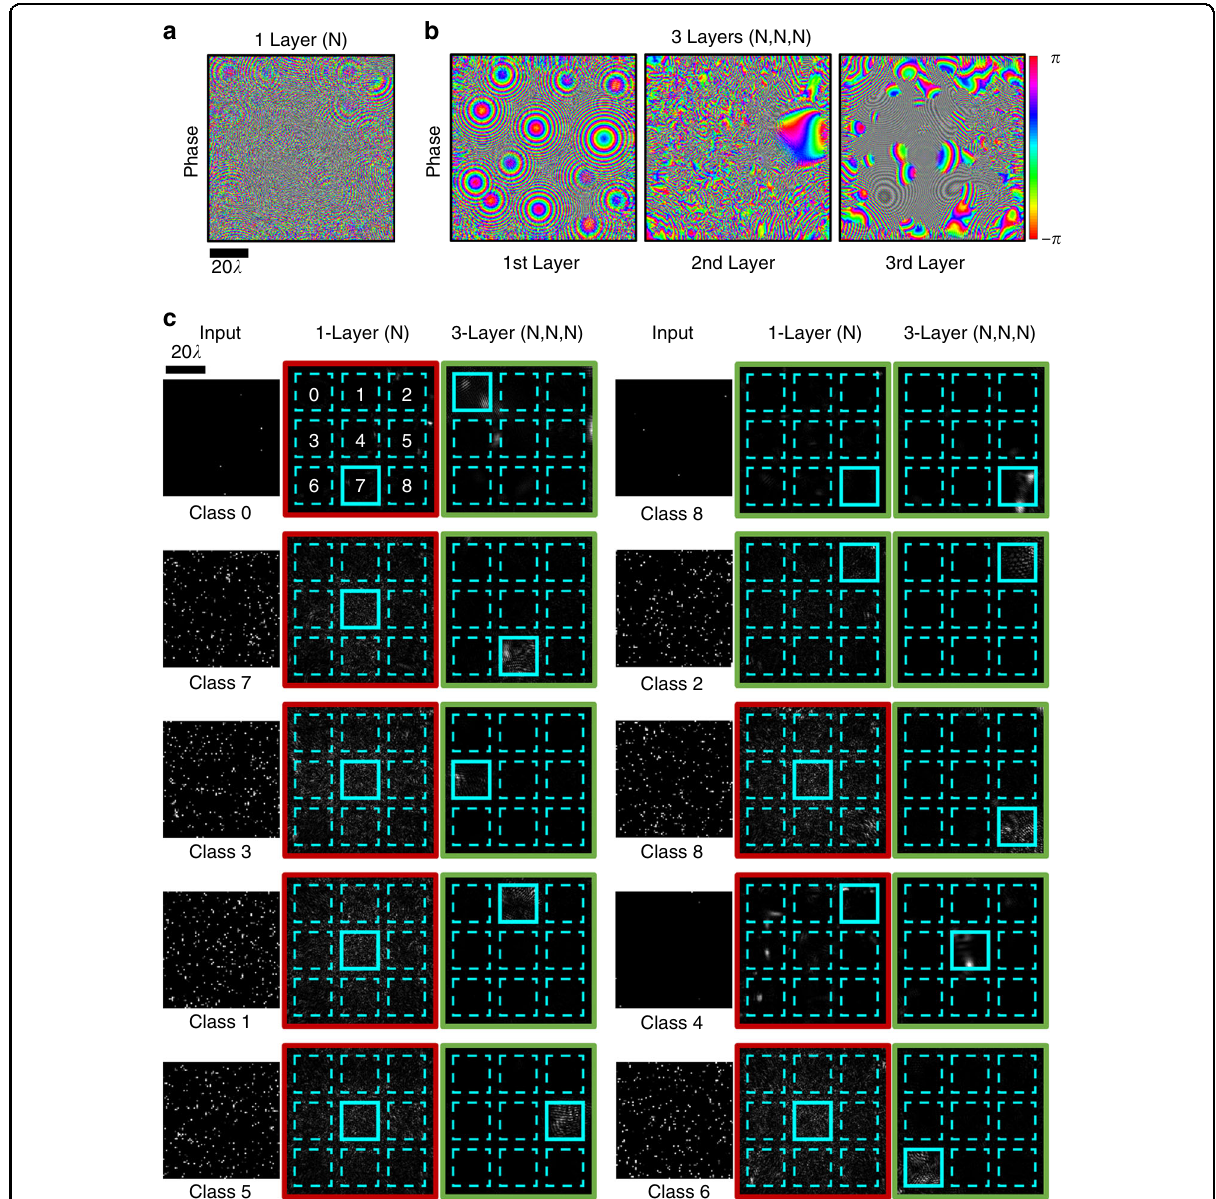
Fig. 5 One- and three-layer phase-only diffractive network designs and their input – output-intensity pro fi les. a The phase pro fi le of a single diffractive surface trained with Tr 1 . b Same as in a , except that there are three diffractive surfaces trained in the network design. c The output-intensity distributions for the 1- and 3-layer diffractive networks shown in a and b , respectively, for different input images, which were randomly selected from Te 1 and Te 50 . A red (green) frame around the output-intensity distribution indicates incorrect (correct) optical inference by the corresponding network. N =